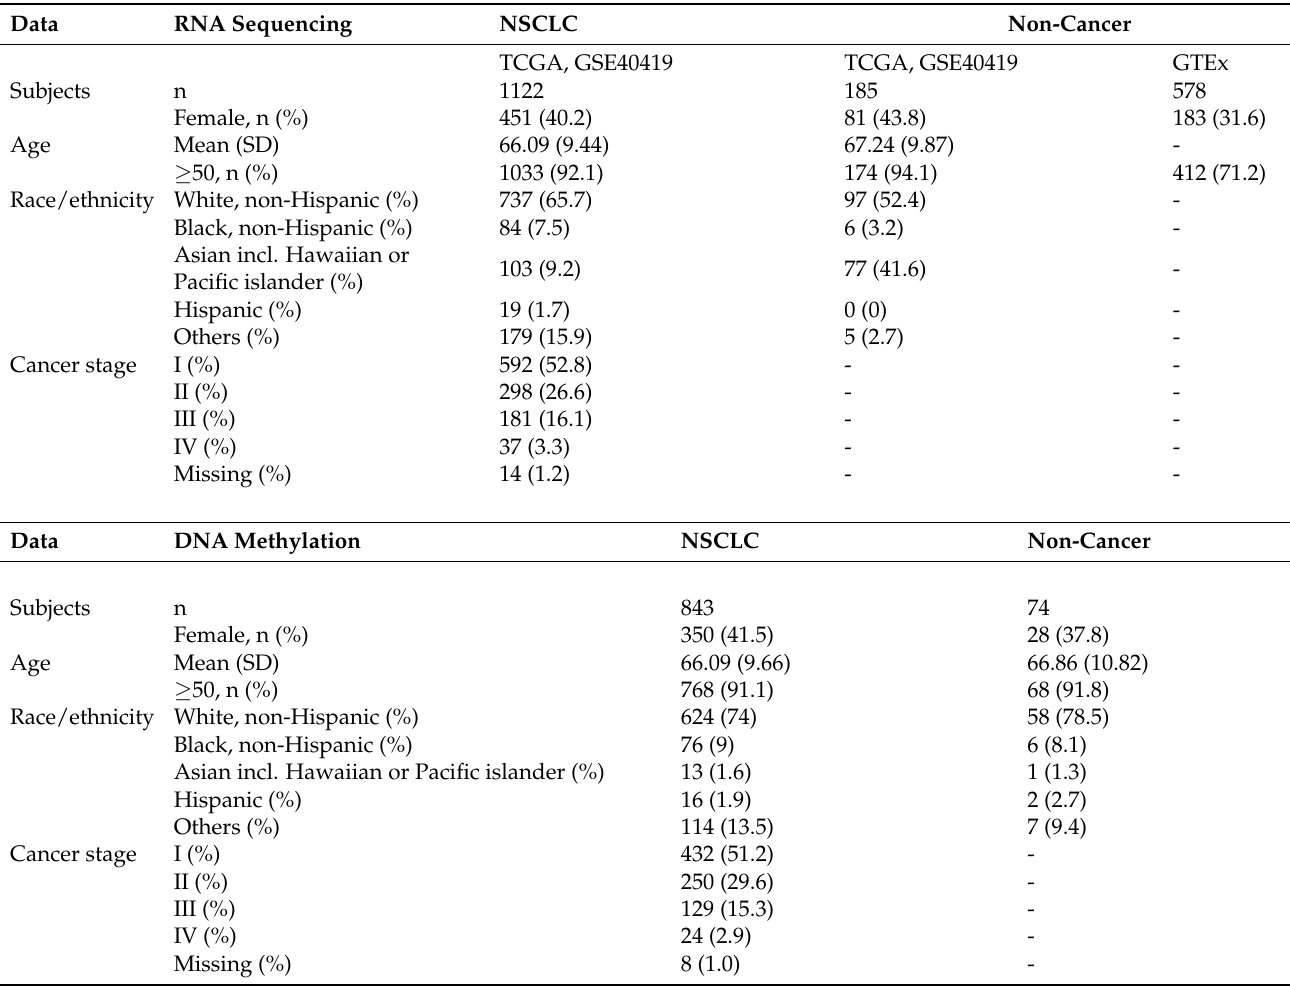
Table 2. Baseline demographics of